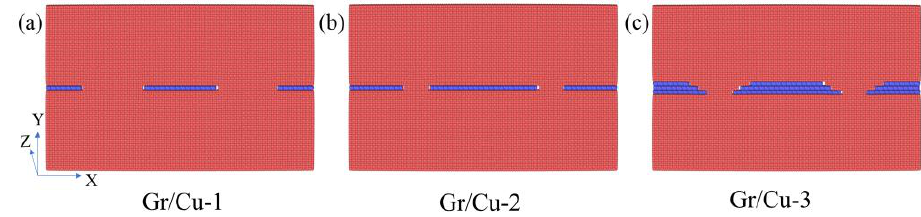
Figure 1. Two-dimensional view of ( a ) Gr/Cu-1, ( b ) Gr/Cu-2, and ( c ) Gr/Cu-3. The tensile process of composites was simulated by molecular dynamics simulation. The tensile process of composites was simulated by molecular dynamics